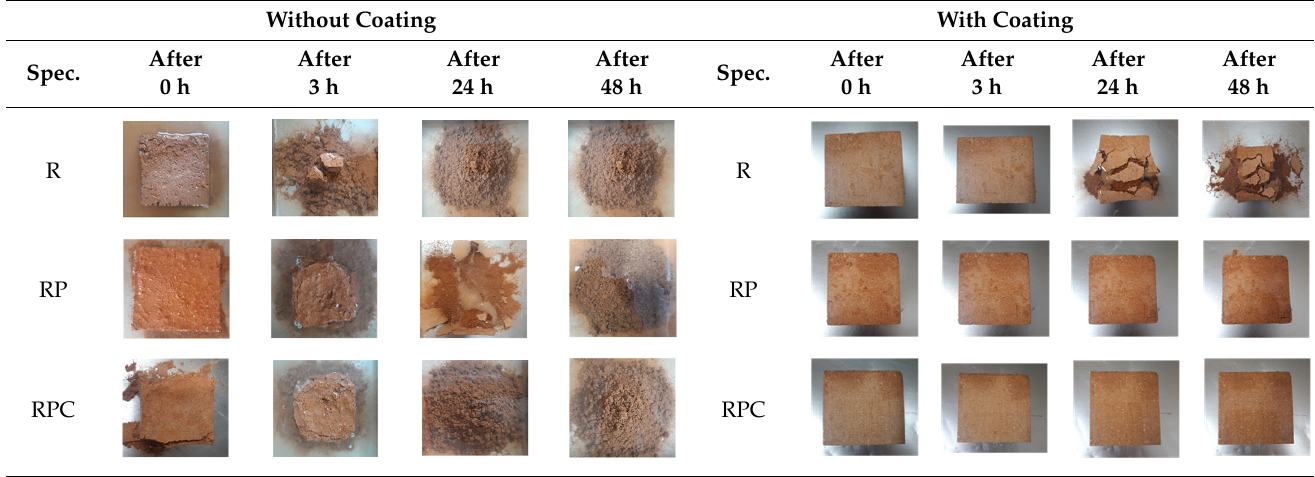
With Coating With Coating